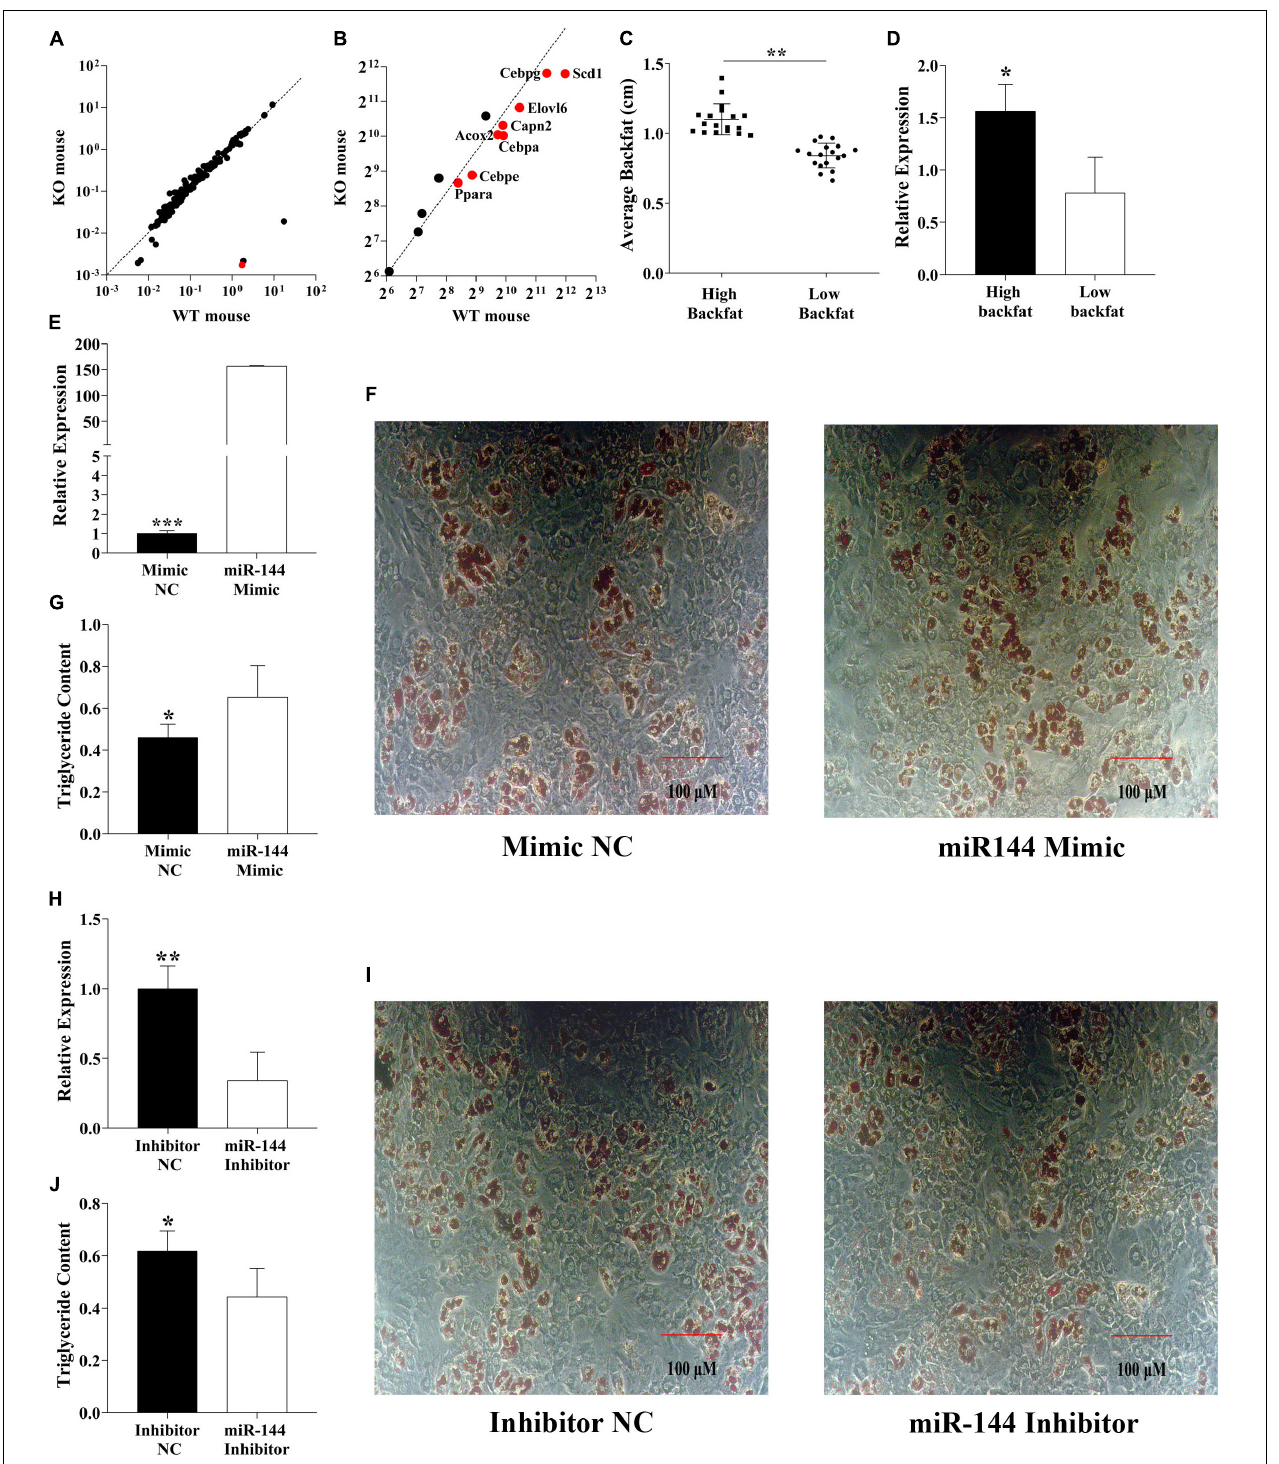
FIGURE 1 | MiR-144 promotes pre-adipocyte differentiation. (A) Mouse knockout data from the GEO dataset (GSE104441) show the miR-144 specific knockout in mouse liver tissue. The red dot means miR-144. (B) Analysis of the adipogenic label genes in the GEO datasets (GSE104441). The above two dotted lines mean the standard line. (C,D) Detected miR-144 expressed in two backfat thickness groups. (E–G) Overexpressed miR-144-3p mimics in pre-adipocytes (E) then after 8-day differentiation inducer medium (DIM) stimulation, oil red O staining (F) , and triglyceride assay (G) , the results identified that miR-144 promoted pre-adipocyte differentiation. (H–J) Specific interference of miR-144 by its inhibitor confirms its regulatory function on adipogenesis. After statistical analysis, * in the figure indicates p < 0.05, ** p < 0.01, and *** p < 0.001.